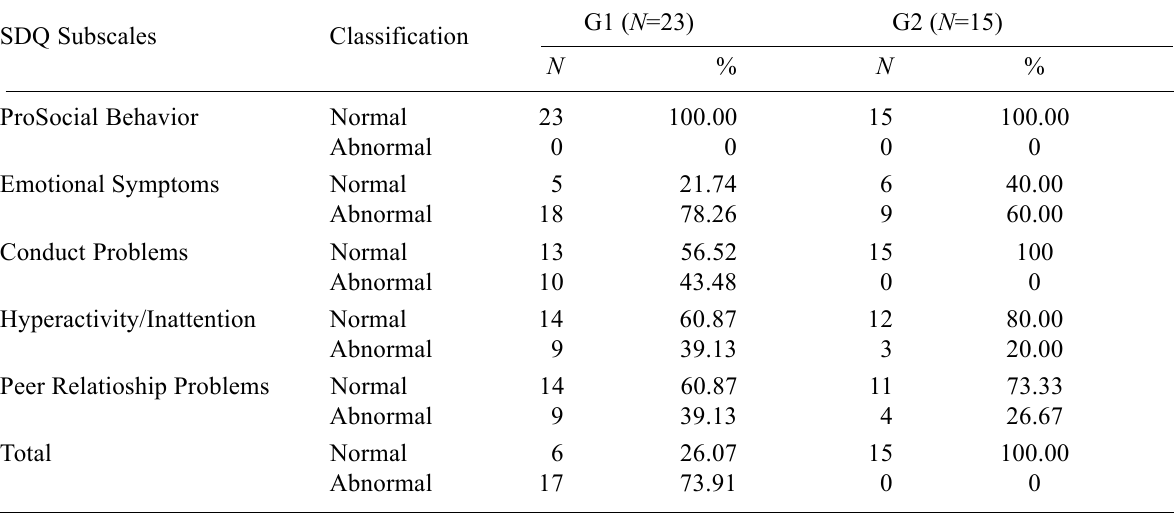
Frequency and Percentages of Children’s Classification in SDQ subscales and Total Scores, According to Presence (G1) or Absence (G2) of Behavior and School Performance Difficulties SDQ